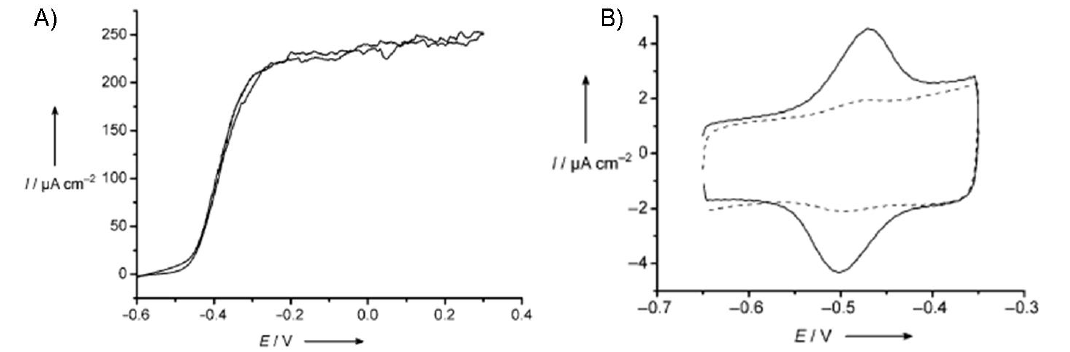
Cyclic voltammograms of GOx (dotted line) and dGOx (solid line) adsorbed on glassy carbon electrodes. Reprinted from reference [94]. Copyright Wiley-VCH Verlag GmbH